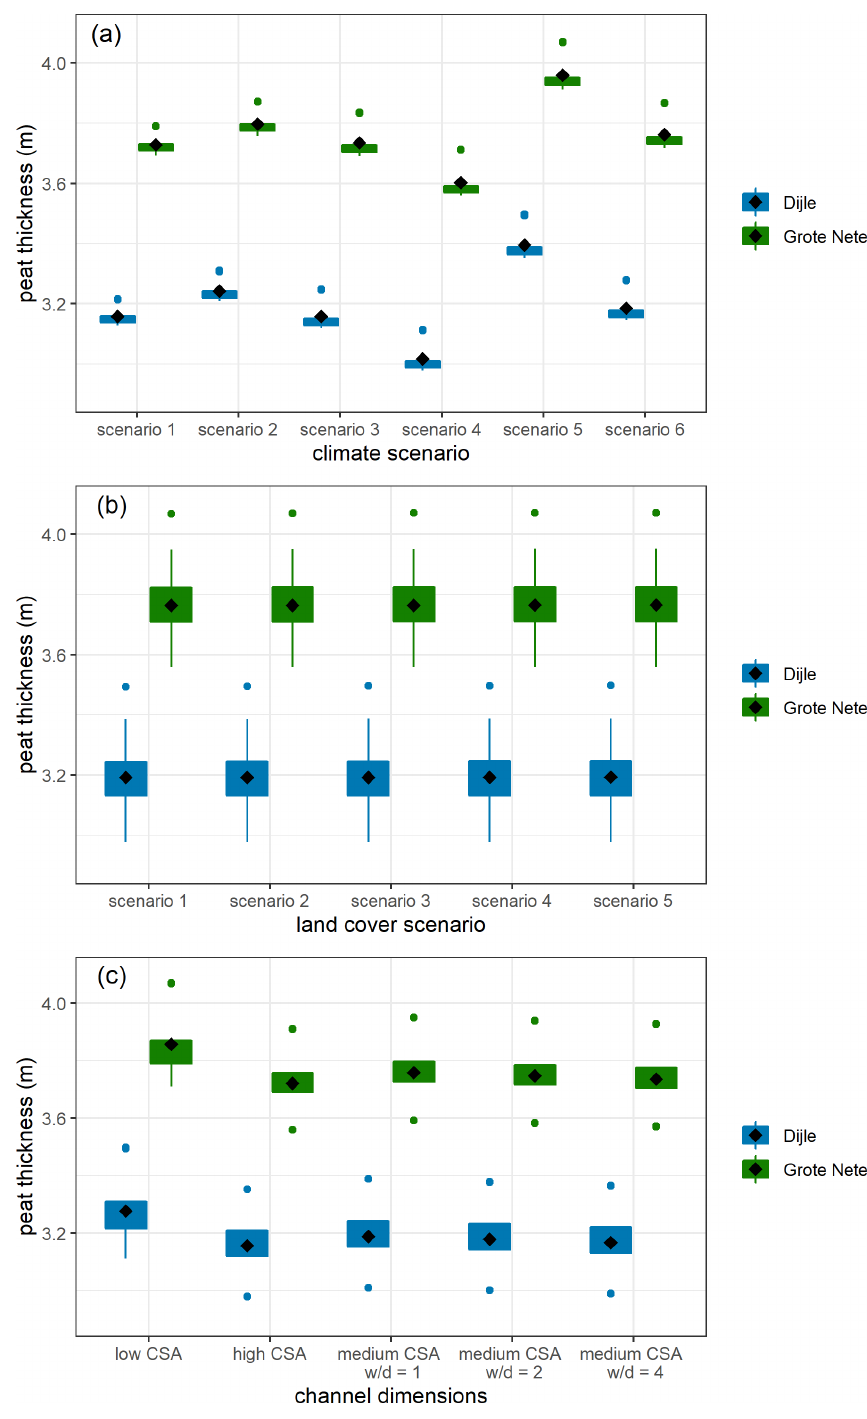
Figure 10. Boxplots of the simulated peat thickness (m) for all scenario combinations with four river channels, over a time period of 10000 years for the Dijle and Grote Nete rivers, subdivided per climate scenario (a) , land cover scenario (b) and channel dimensions (c) . The mean value is indicated by a black diamond. The box indicates all values within the 25th to 75th percentile range, and the whiskers represent all values within the range from the 25th percentile to 1.5 times the interquartile range to the 75th percentile plus 1.5 times the interquartile range. Coloured dots represent all other values outside this